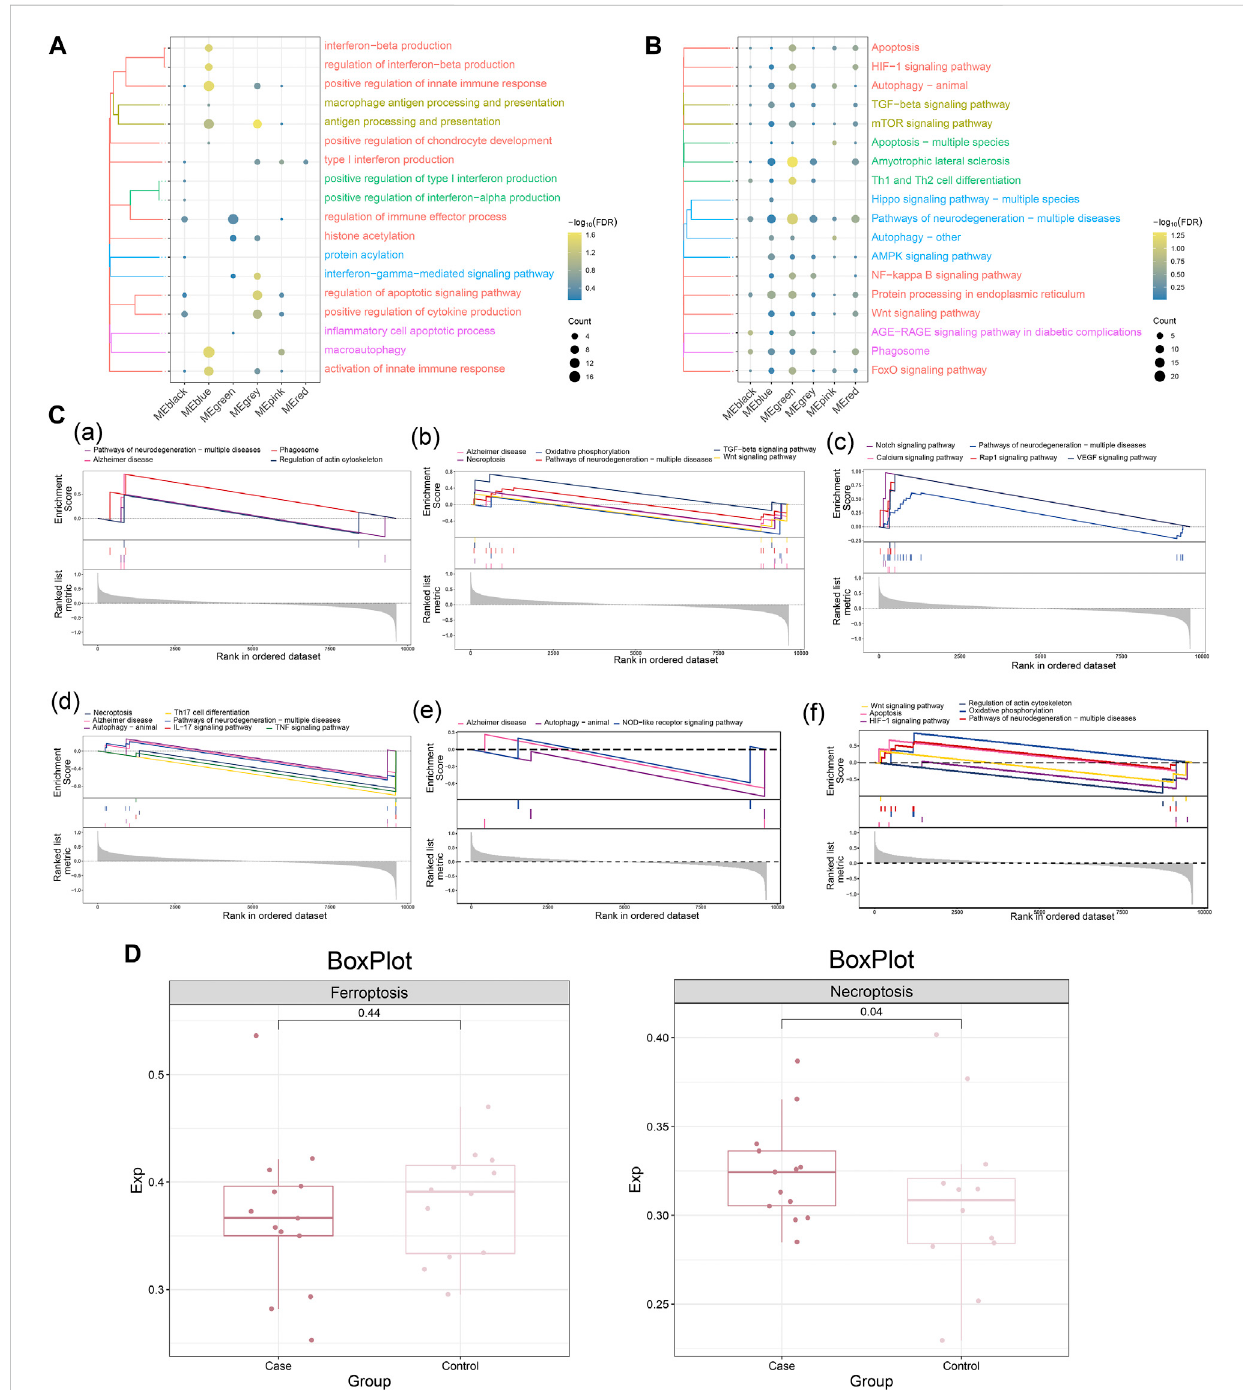
FIGURE 3 Biological functions and signaling pathways signi fi cantly involved in myasthenia gravis dysregulated gene co-expression modules. (A) Clustered bubble plots showing the biological functions signi fi cantly regulated by MG dysregulated gene co-expression modules (listed as different modules). (B) Clustered bubble plots showing the signaling pathways signi fi cantly regulated by MG dysregulated gene co-expression modules (listed as different modules). (C) ComprehensiveGSEA diagramshowingsignaling pathwayssigni fi cantly activated/repressed byMGdysregulatedgene co-expression modules, (a) blackmodule, (b) bluemodule, (c) greenmodule, (d) graymodule, (e) pinkmodule, (f) redmodule. (D) Scoringofferroptosisandnecroptosis in MG and control